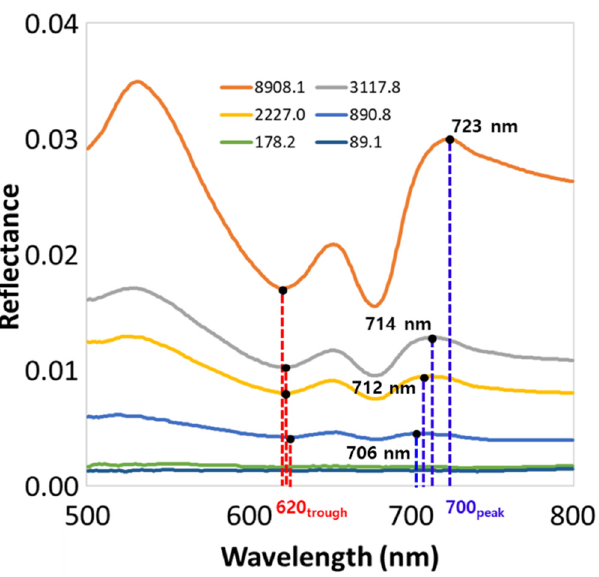
Figure 3. Spectral measurement results from the darkroom experiment. The reflectance spectra of samples with six different PC levels show a strong trend of peak shift being proportional to PC concentration in cultured Microcystis aeruginosa.